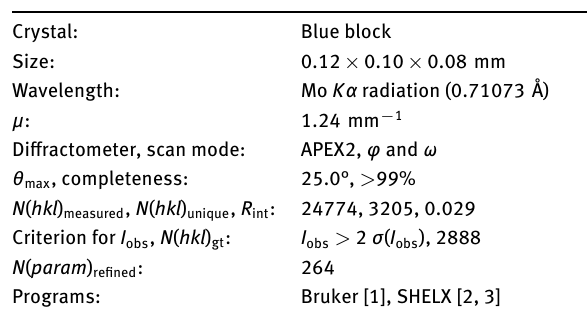
Table 1: Data collection and handling.